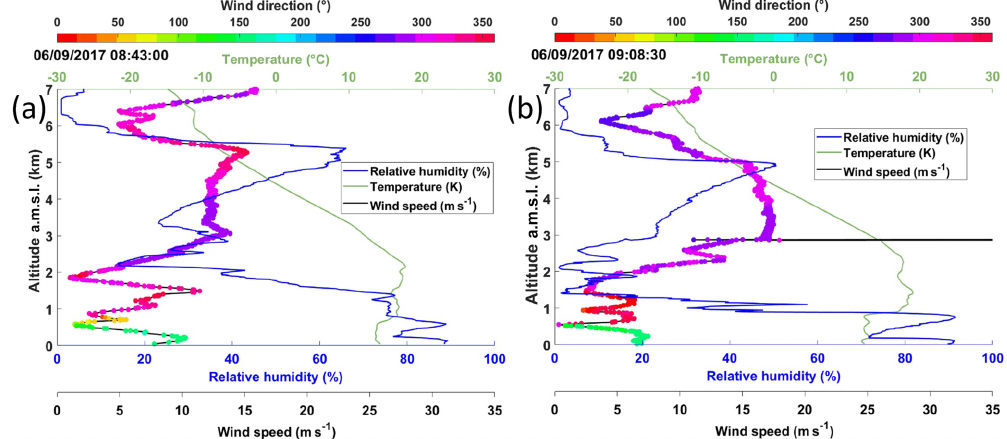
Figure 11. (a, b) Same as Fig. 7b but for the dropsondes released at 08:43UTC (to the northwest of Henties Bay; dropsonde no. 2 in Fig. 10a) and at 09:08UTC (west of Henties Bay; dropsonde no. 1 in Fig.